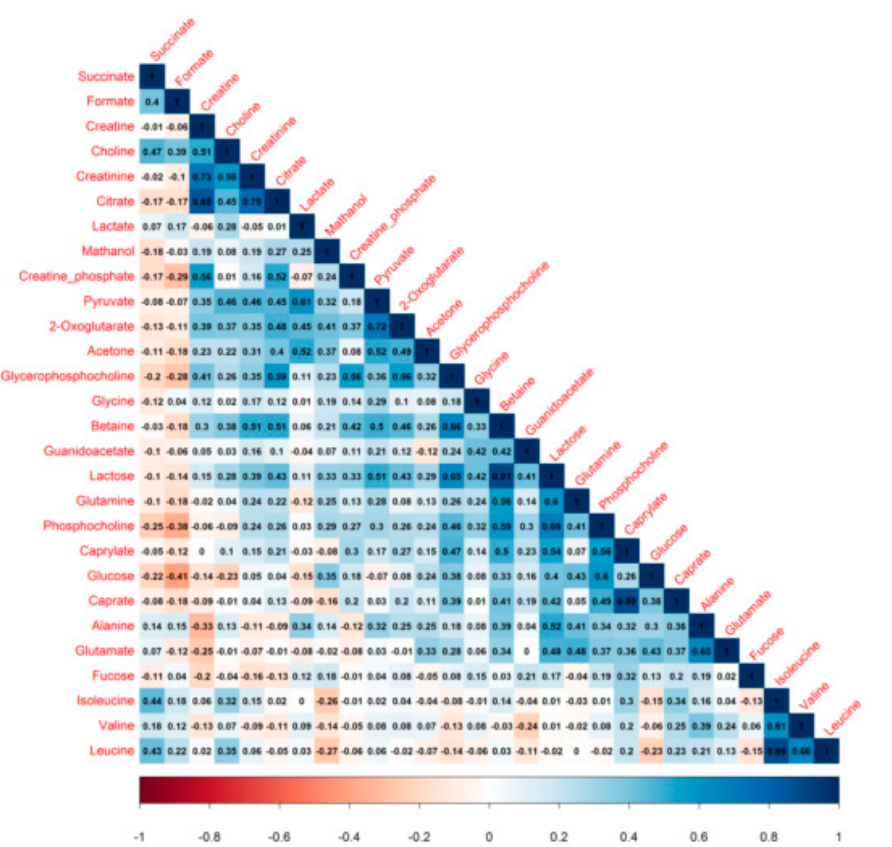
Figure 3. Correlation plot of 28 human milk metabolites from non-atopic mothers. Values shows Pearson correlation coefficients between pairs of metabolites. Positive correlation, zero correlation and negative correlation are represented by colors ranging from blue to white to red, respectively.